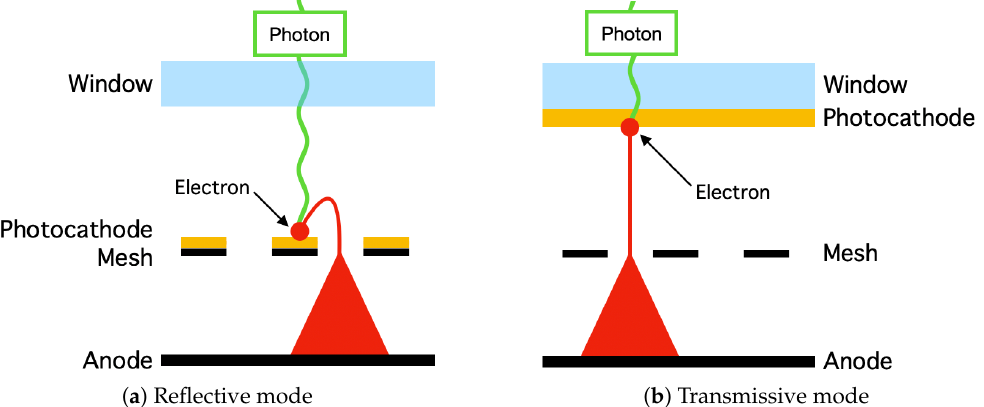
Figure 24. Sketch of UV-photon detection with Micromegas in ( a ) reflective- and ( b ) transmis- sive